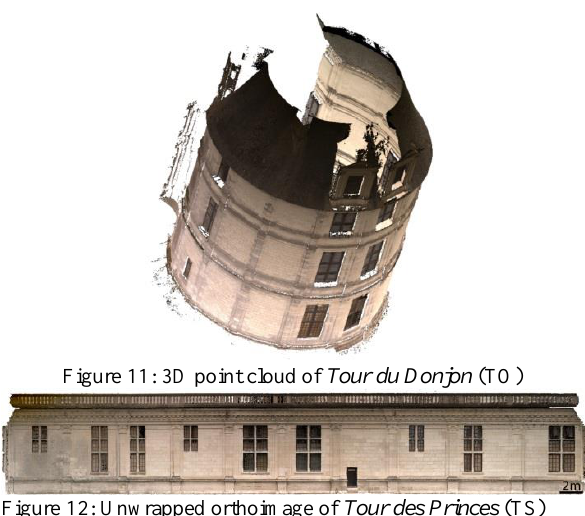
Figure 12: Unwrapped orthoimage of Tour des Princes